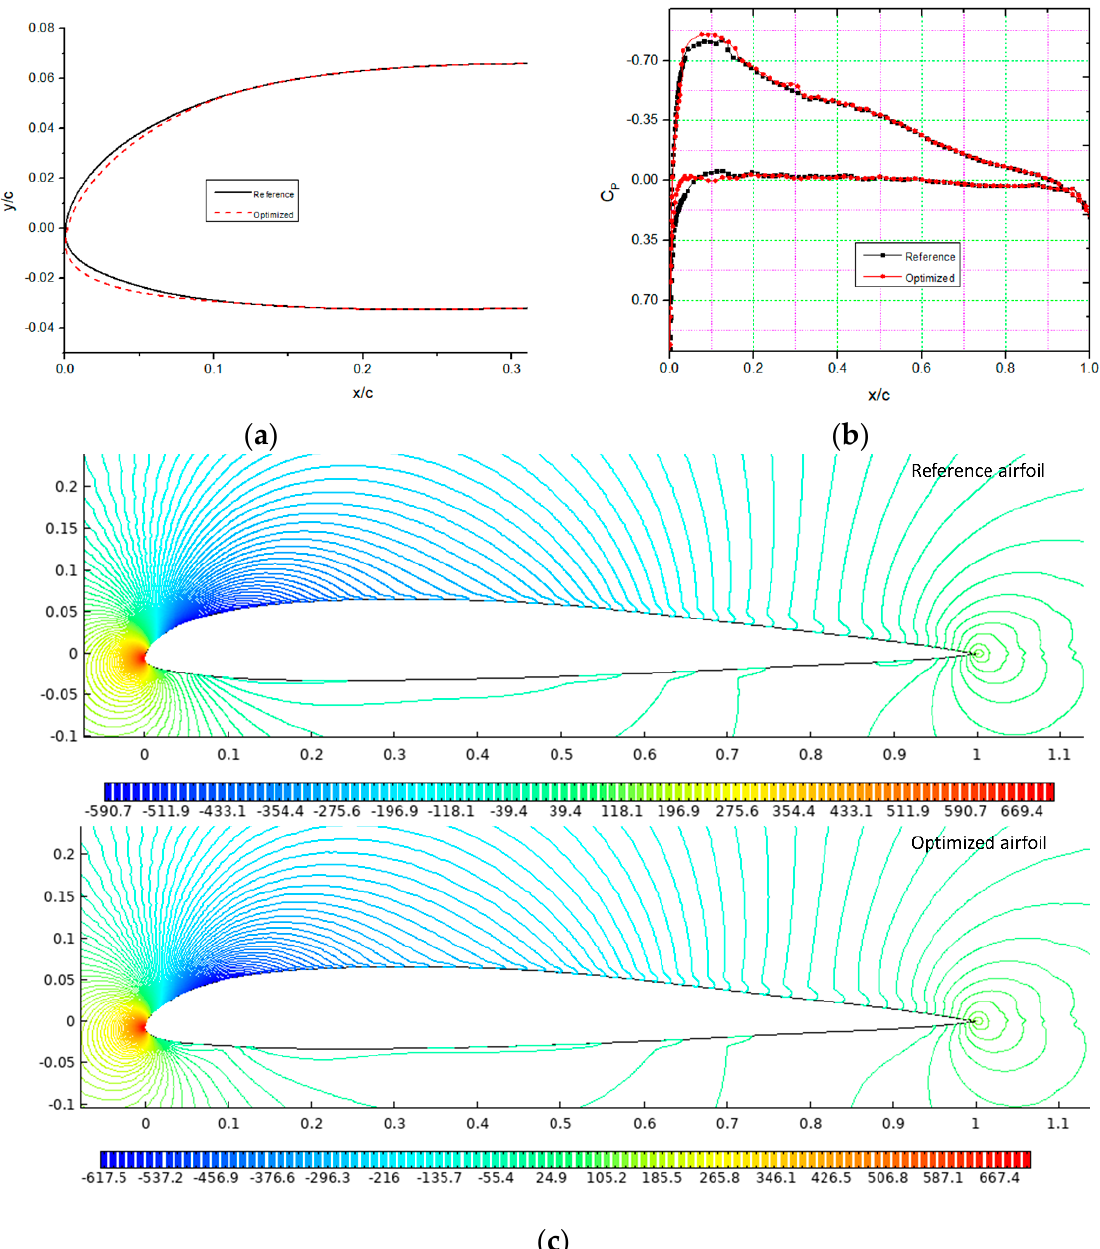
Figure 16. Comparison of results for the S45 optimized airfoil for maximized aerodynamic endur- ance: ( a ) Airfoil shape; ( b ) Cp distribution; ( c ) Pressure variation over the airfoil.